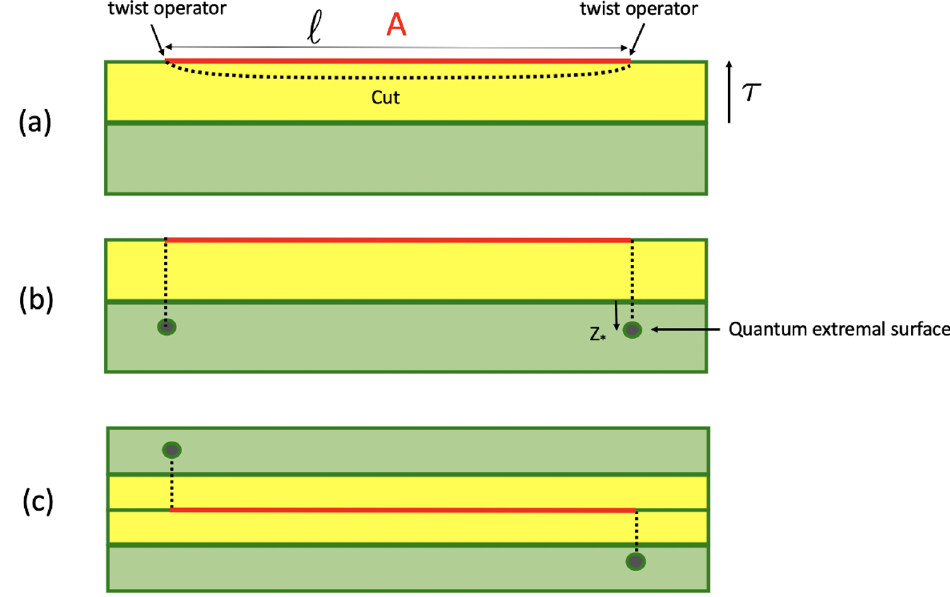
Figure 3 . We consider a region A in the state produced by the gravitational (green) plus the field theory (yellow) Euclidean evolution. (a) The naive result with no islands which just gives the field theory entropy of the interval in the vacuum. (b) The entropy when there are non-trivial quantum extremal surfaces. When ‘ is large the two intervals, represented by the dotted lines, are very far away. (c) The full computation involves two sides corresponding to the bra and the ket, here represented above and below the red interval. We can put the quantum extremal surface on either side indpendently for each of the two extremal